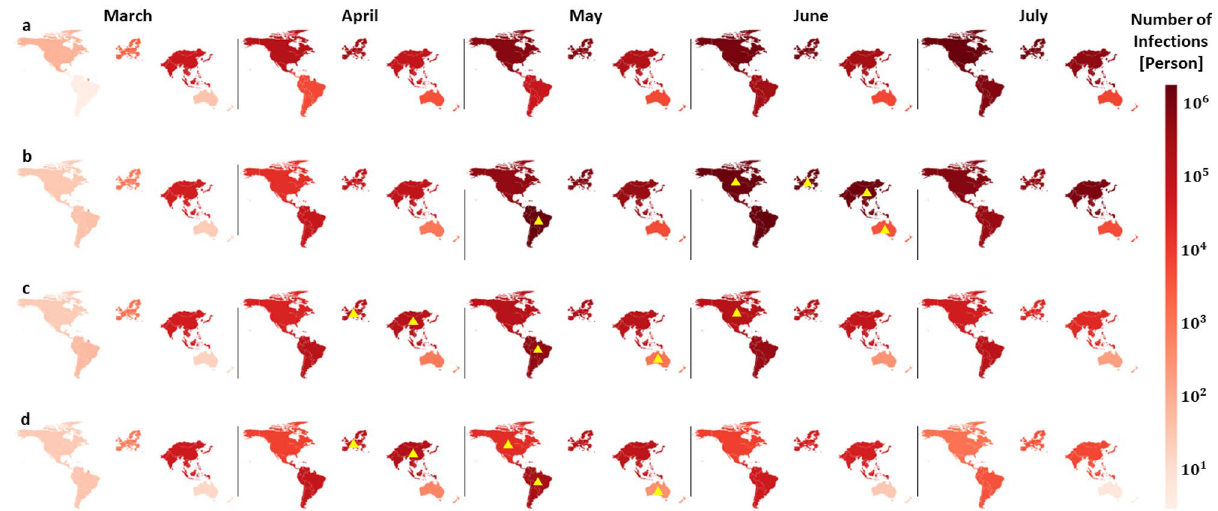
Figure 5. Impacts of strategies on infections. (a) Actual infections between March 2020 and July 2020 caused by the on-going COVID-19 pandemic. (b) Simulated infections using the PE containment strategy. (c) Simulated infections using the PE containment strategy. (d) Simulated infections using the OCN strategy. The color intensity in each region represents the number of infections. The yellow triangles mark the occurrence of a peak in